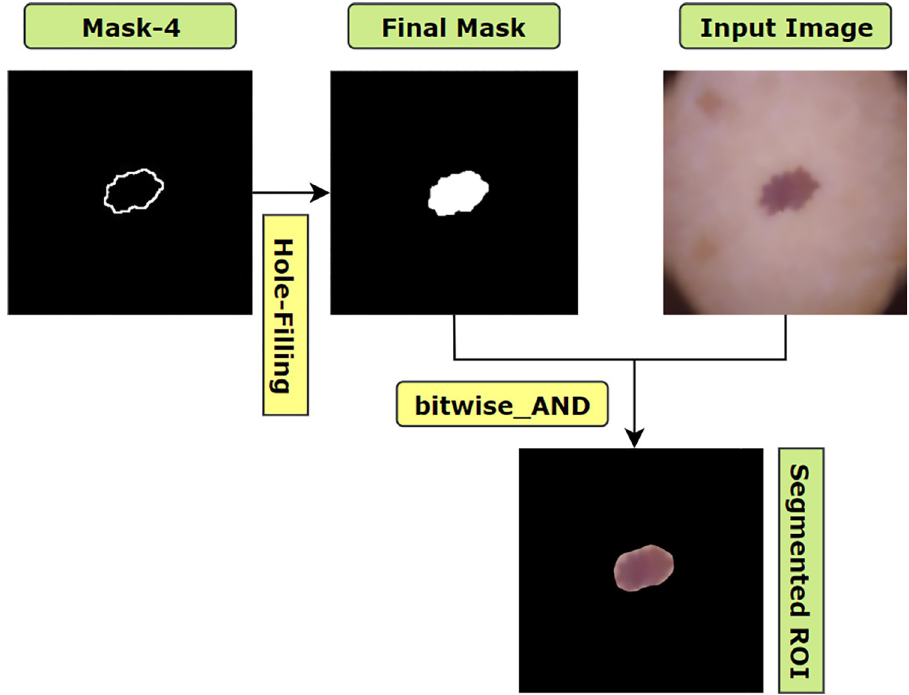
Fig 15. Process of extracting ROI by filling the largest